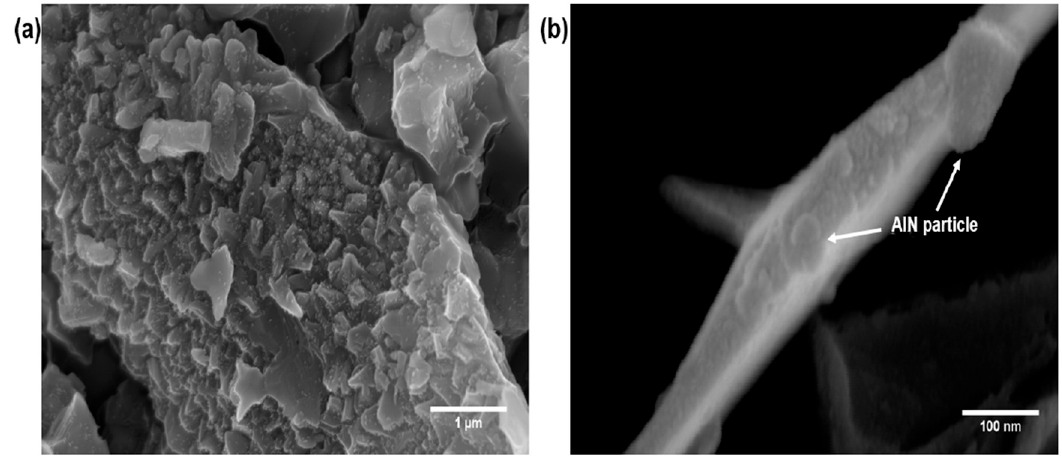
Figure 5. FE-SEM image of ( a ) AlN particles; and ( b ) AlN grafted MWCNTs.